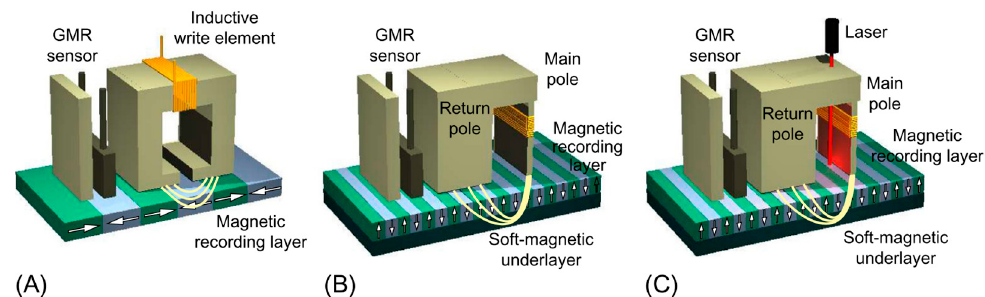
Figure 2. Sketches comparing ( A ) longitudinal magnetic recording (LMR), ( B ) perpendicular magnetic recording (PMR), and ( C ) heat-assisted magnetic recording (HAMR) technologies. In LMR and PMR, the data bits are aligned parallel and perpendicular to the surface of the disk, respectively. The latter configuration reduces the repelling forces between bits and enables higher write magnetic fields, allowing higher areal recording densities. HAMR uses thermal laser heating of the magnetic medium to write data at high temperatures, enabling the use of smaller write magnetic fields and thus magnetic recording layers with smaller grain size and higher anisotropy. This not only improves the long-term stability of the magnetic information but also allows to further increase the areal bit density Reprinted with permission from ref. [1] 2018 Elsevier.